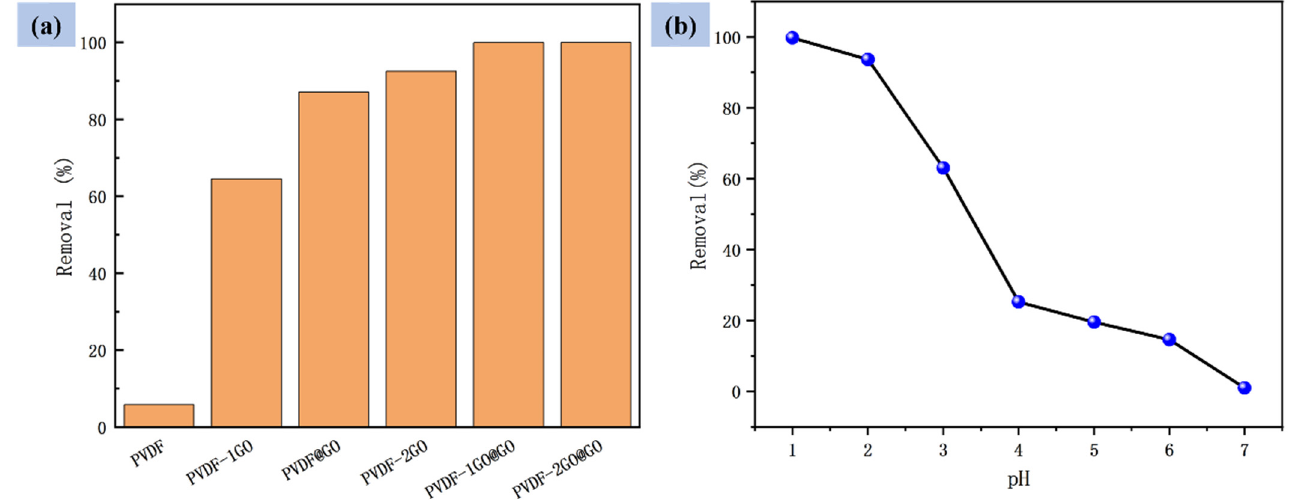
Figure 5. ( a ) Comparison of adsorption effect of different nanofibers and ( b ) effect of pH on the adsorption capacity by the PVDF–2GO@GO nanofibers.